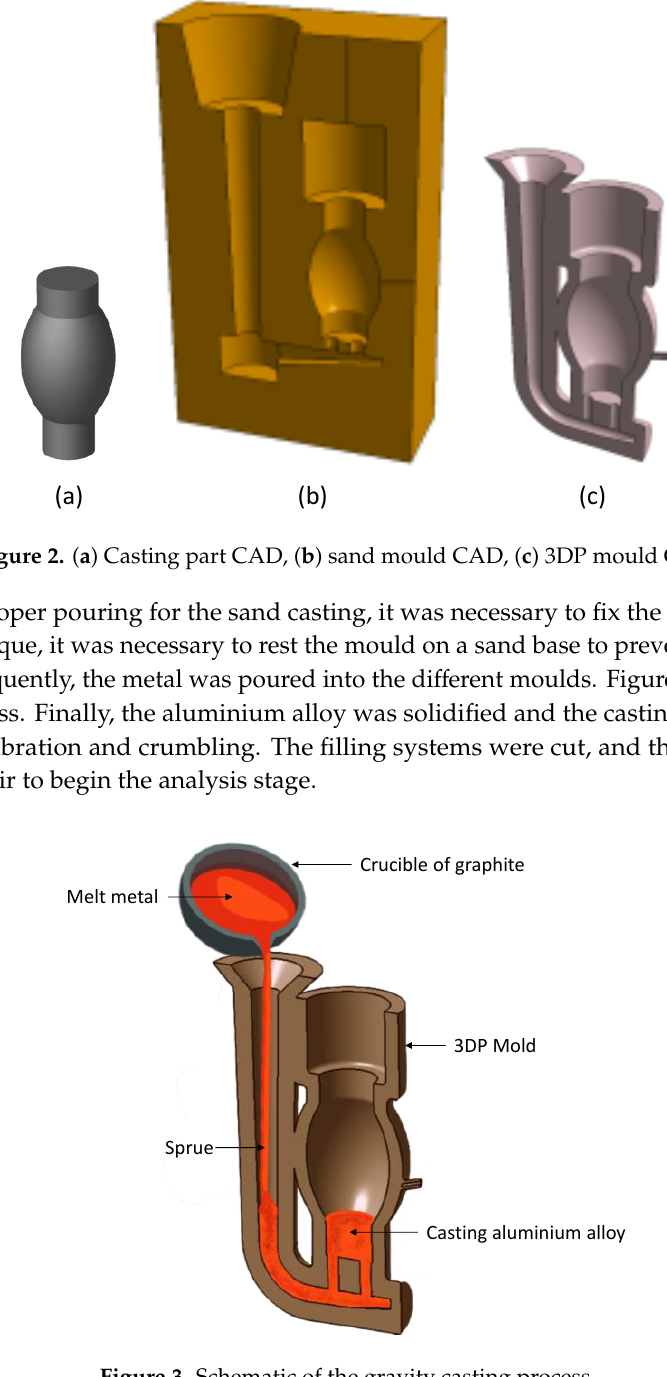
Figure 3. Schematic of the gravity casting process.